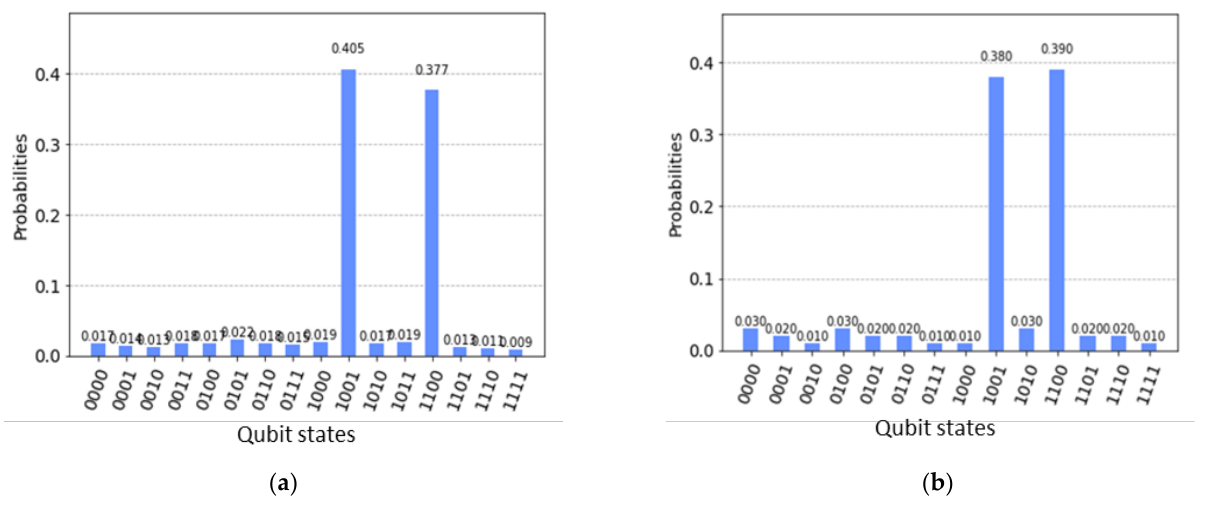
Figure 7. ( a ) QasmSimulator results when the number of shots = 1024, and ( b ) when the number of shots = 8192.